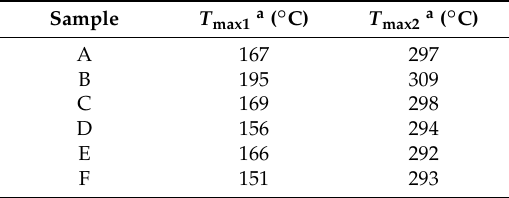
Figure 7. Stress–strain curves of different SPI-based films.